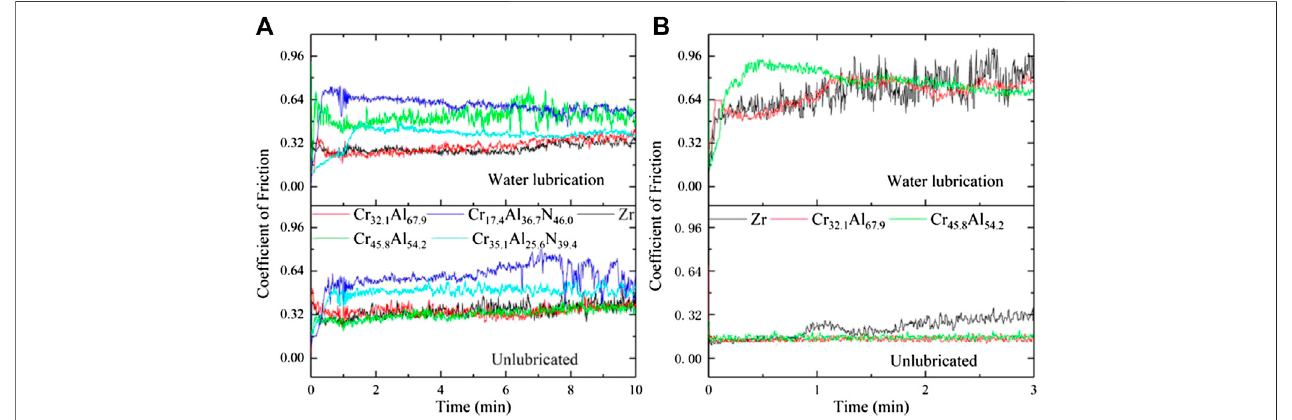
FIGURE 5 | Coef fi cient of friction of various ATF candidates and Zr-4 under different load: (A) 5 N, (B) 1 N.